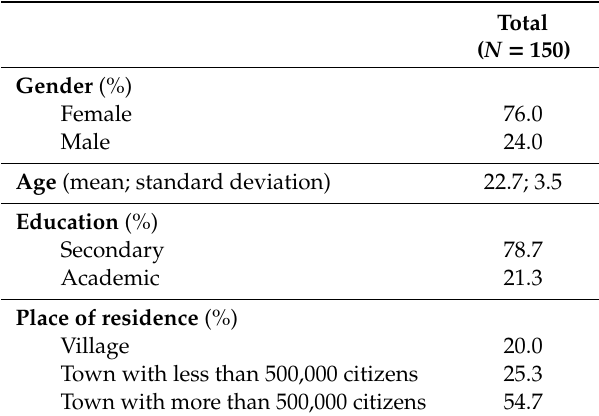
Table 1. Characteristics of the study group